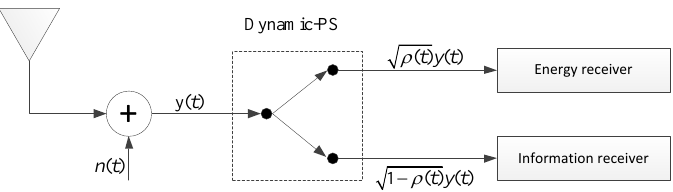
Figure 2. Architecture for the separated information and energy receiver [25].